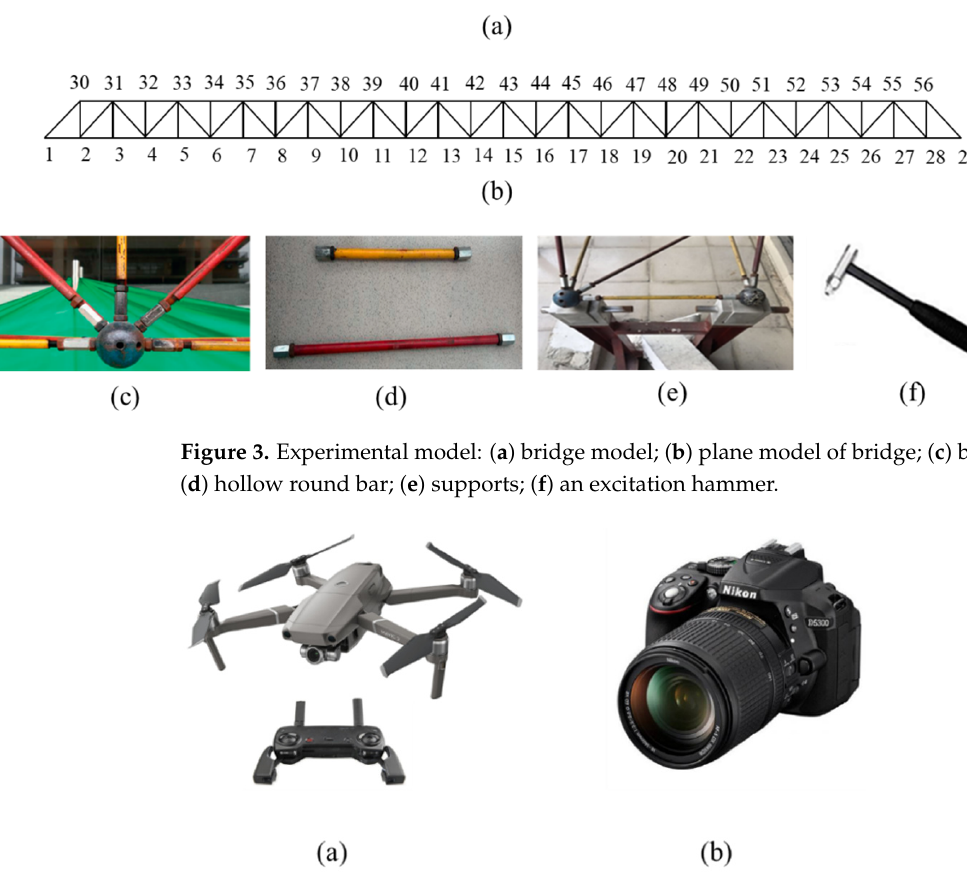
Figure 4. Signal acquisition equipment: ( a ) UAV; ( b ) fixed camera.